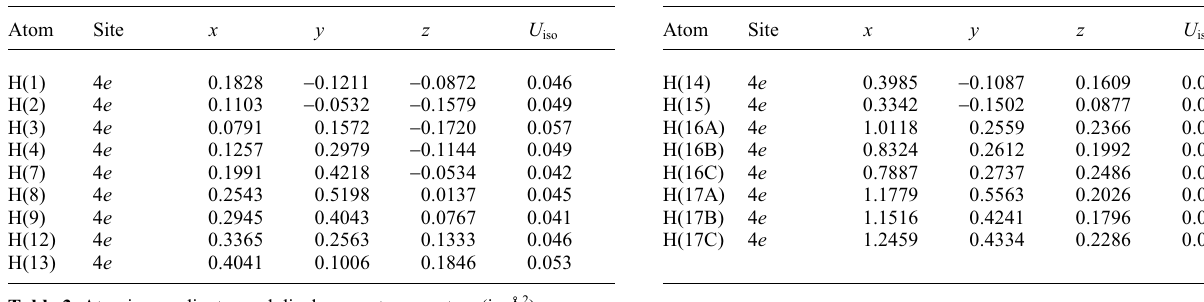
Table 2. Atomic coordinates and displacement parameters (in Å 2 )